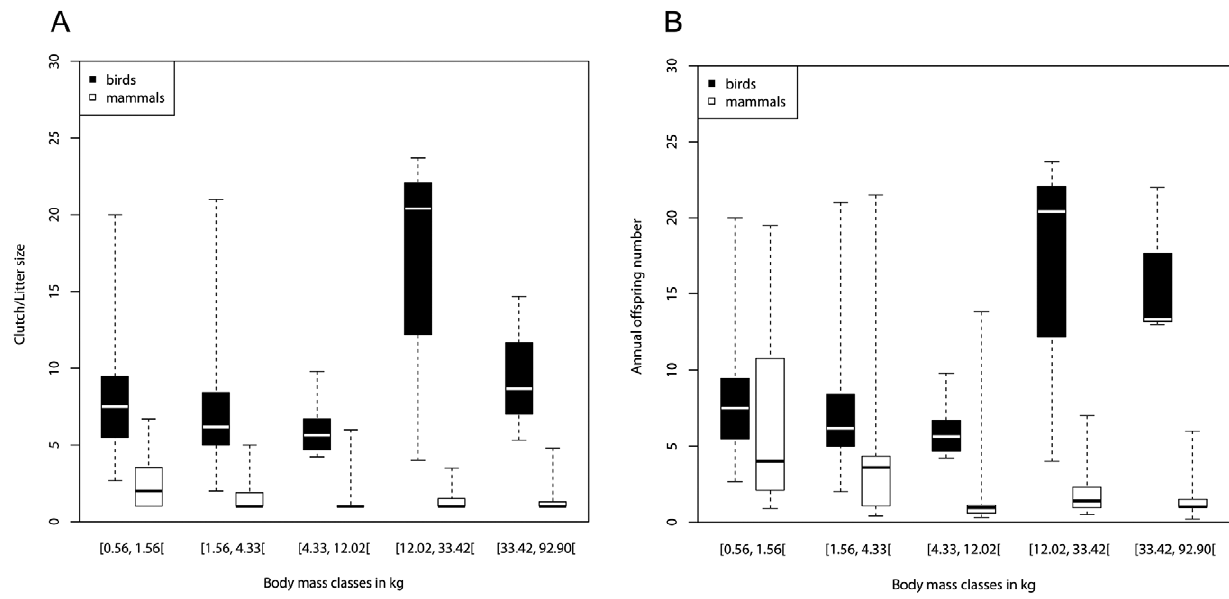
Figure 2. Comparison of the potential reproductive output of birds and mammals for different weight classes. Potential reproductive output is measured as medians of clutch/litter sizes (A) and medians of annual offspring number (B) for species groups of different weight classes. Each weight class interval has a width of 0.444 (unit is kg) on a logarithmic scale. Birds of all weight classes had a higher median clutch/litter size than similar-sized mammals. Similar-sized birds had on average (median) more offspring per year than mammals in all weight classes. For the detailed results of the statistical analyses, refer to the text. Box plots show medians, quartiles, minima and maxima of clutch sizes and litter sizes.